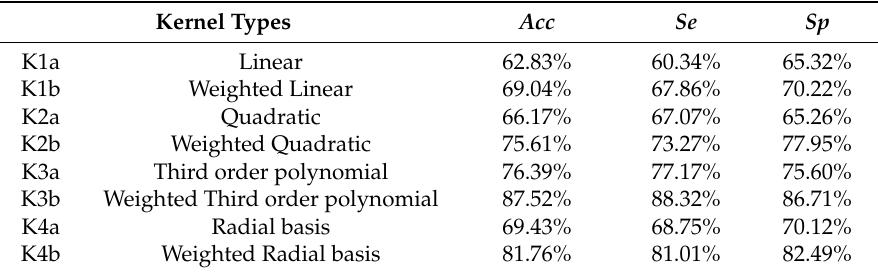
Table 2. Comparison of typical kernel based classifier.